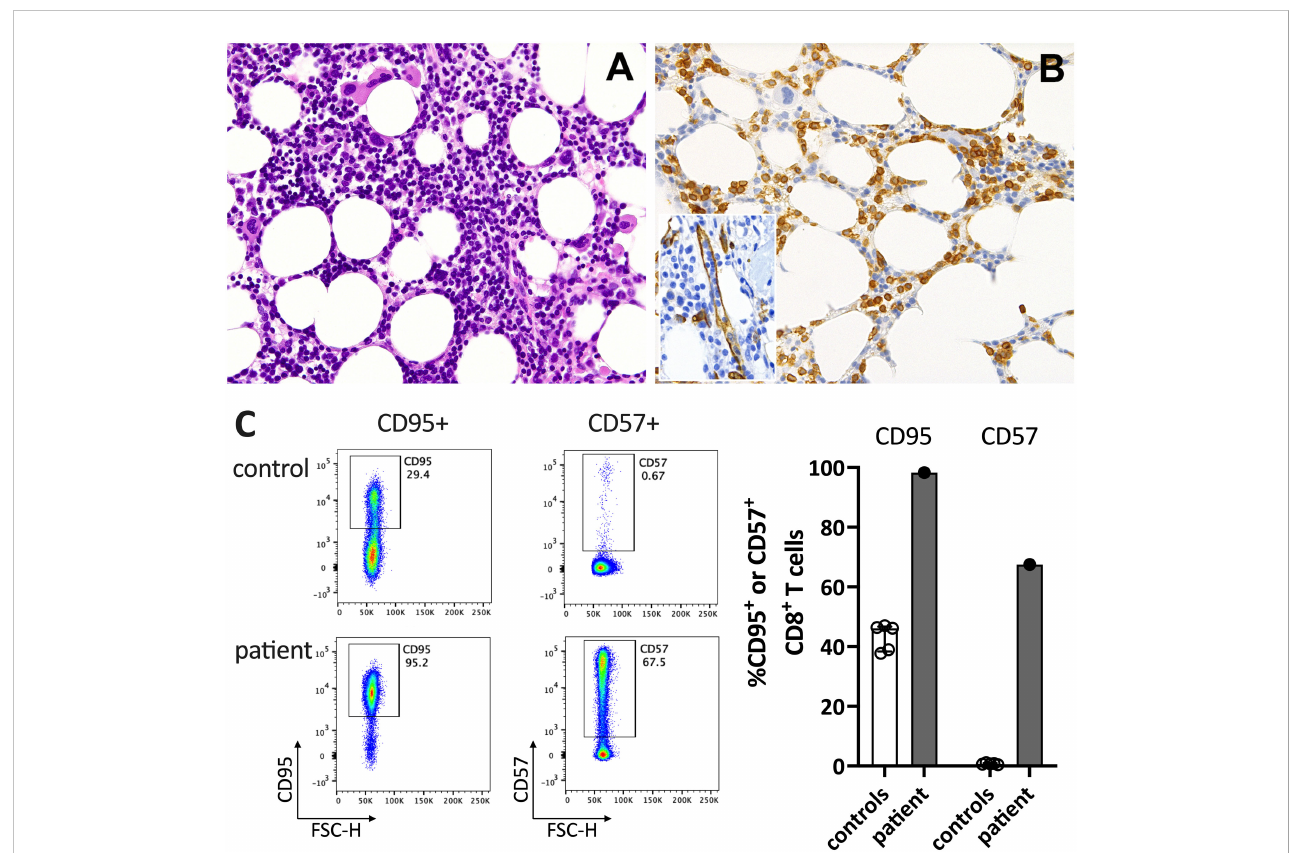
FIGURE 2 Immunohistochemistry of the bone marrow compatible with T-LGL. (A) H&E staining shows a hypercellular bone marrow with slightly increased and left- shifted megakaryopoiesis, substantially reduced and left-shifted myelopoiesis, and interstitial lymphocytosis. (B) Immunohistochemistry for anti-CD3 (T cells) con fi rmed signi fi cant interstitial T-cell lymphocytosis with some linearity and intravascular spread (shown as an insert in the fi gure; anti-CD34 was used to mark the vessels). Magni fi cation 400x (CD3) and 630X (insert; CD34). (C) Flow cytometry plots (left) and data summary graph (right) show high CD95 and CD57 expression on T cells of the patient compared to healthy controls (ctrl; n=5). FSC-H= forward scatter height.